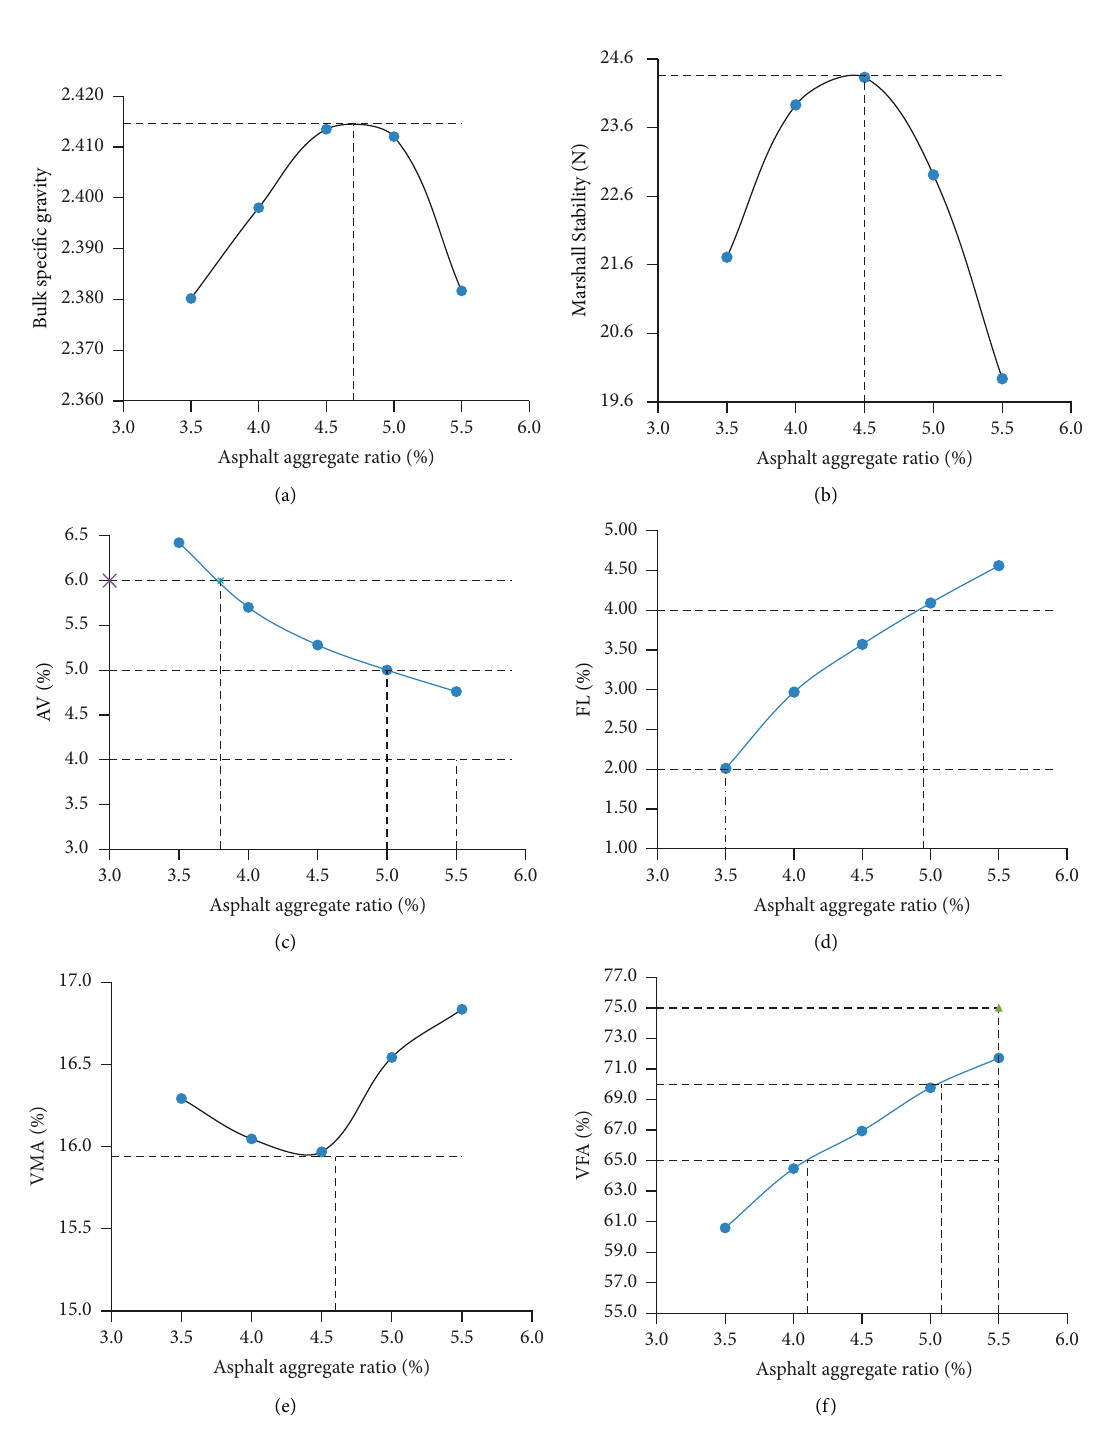
Figure 3: Design plots for Marshall mix